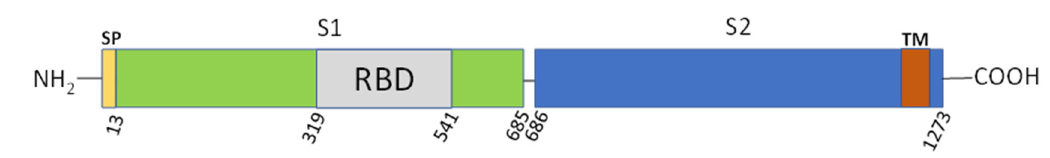
Figure 1. Structure of SARS-CoV-2 spike protein. The spike (S) protein has two major domains, subunit 1 (S1) and subunit 2 (S2). The receptor-binding domain (RBD) that binds to ACE2 is amino acid Arg319-Phe541 of the S1 domain. A 13 amino acid signal peptide (SP) is present at the start of the amino terminus, while the transmembrane domain (TM) is located near the C-terminus (amino acids 1214–1234). The numbering was taken from [44], and a more detailed representation can be found in that reference.